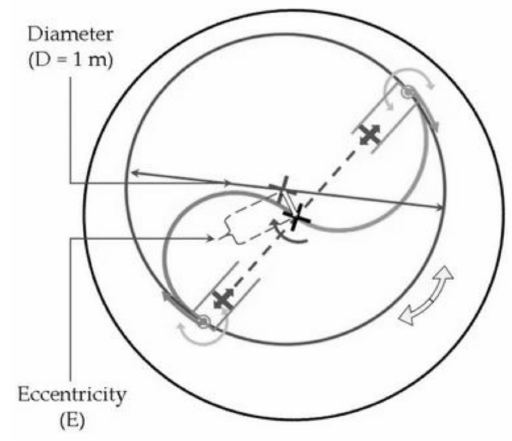
Figure 22. The deformable blade rotor model [89].